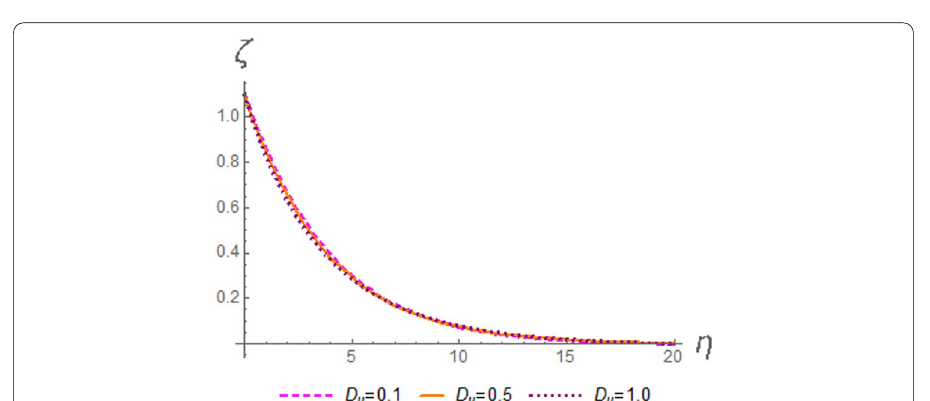
Fig. 18 Effect of D u on the concentration